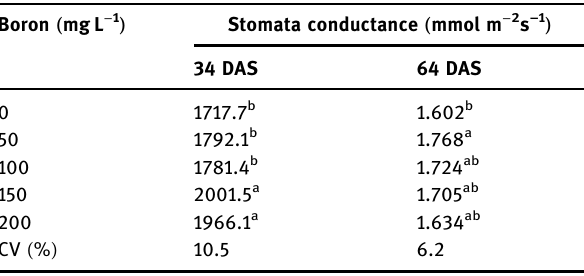
Table 2: Opening and closing of the stomata of sesame at 34 and 64 days after sowing Boron ( mg L − 1